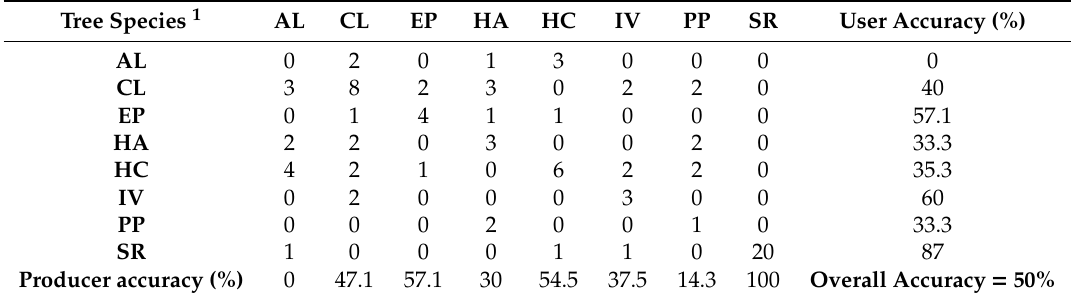
Figure 9. ROC curves of the identification of each tree species from the application of RF to all imagery datasets (Dall_MeanNorm). ( a ) Apuleia leiocarpa (AP), ( b ) Copaifera langsdorffii (CL), ( c ) Endlicheria paniculata (EP), ( d ) Helietta apiculata (HA), ( e ) Hymenaea courbaril (HC), ( f ) Inga vera (IV), ( g ) Pterodon pubescens (PP), ( h ) Syagrus romanzoffiana (SR). Table 7. Confusion matrix of the classification of 8 tree species and all datasets (Dall_MeanNorm) and its user accuracy and producer accuracy.